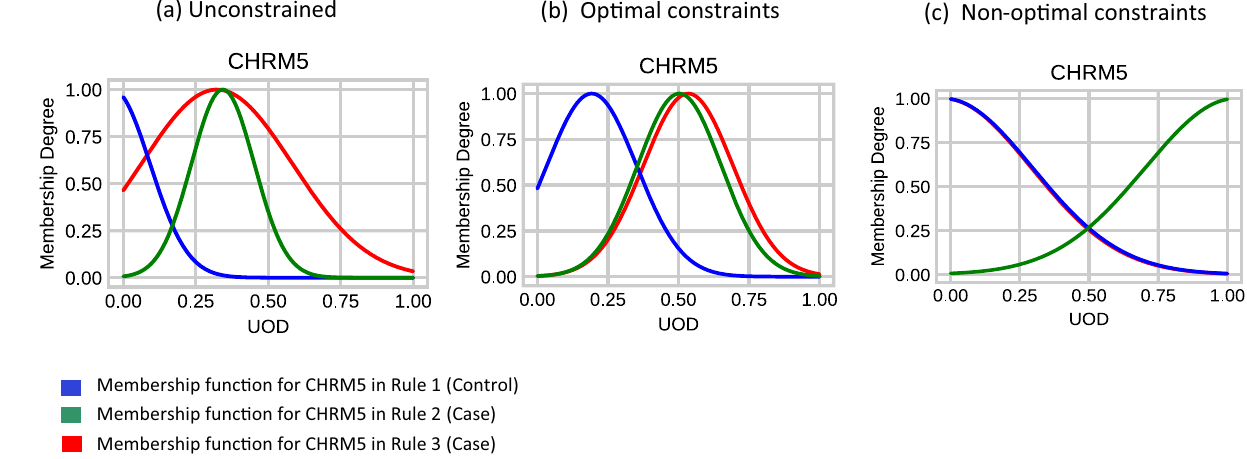
Figure 4. Comparing the effect of constraints on the interpretability of a feature/gene. The three plots ( a ), ( b ) and ( c ) show the three membership functions (belonging to three rules) for the CHRM5 gene, when no constraints are active, optimal constraints are active and non-optimal constraints are active.